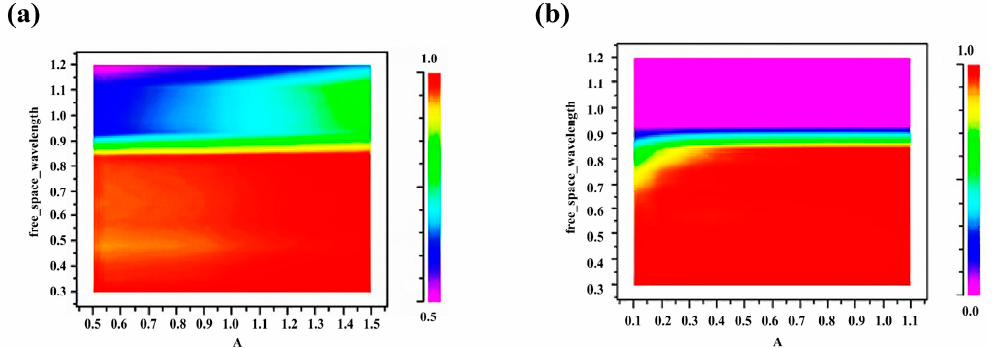
Figure 4. ( a ) The dependance of the absorption efficiency of the absorption layer with KNbO 3 column hexagon scatterers on lattice constant A. ( b ) The dependance of the absorption efficiency of the absorption layer with the air-hole hexagon scatterers on lattice constant A.